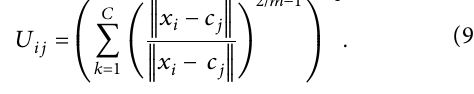
∊ (0, 1), m is the is the degree of membership, U m where U m ij ij weighting exponent which is any number concerning ( 1 ≤ m ≤ ∞ ) , x c i is the data points, j is the centroid of clusters, and C is the number of clusters. Equation (9) indicates the U ij of the data point in the j cluster at any iteration.